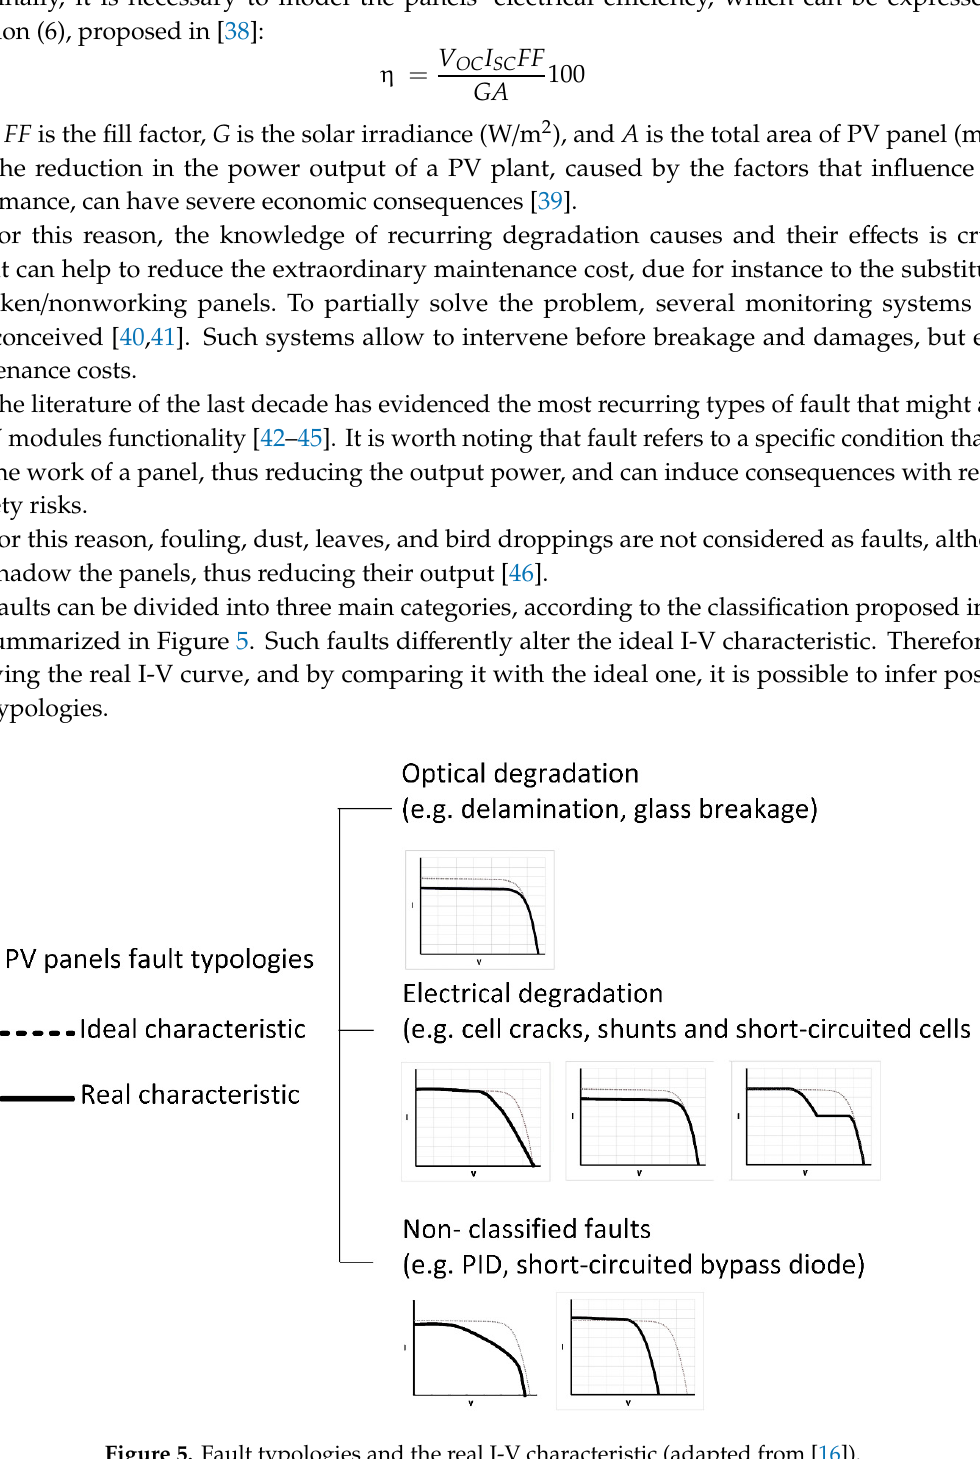
Figure 5. Fault typologies and the real I-V characteristic (adapted from [16]).